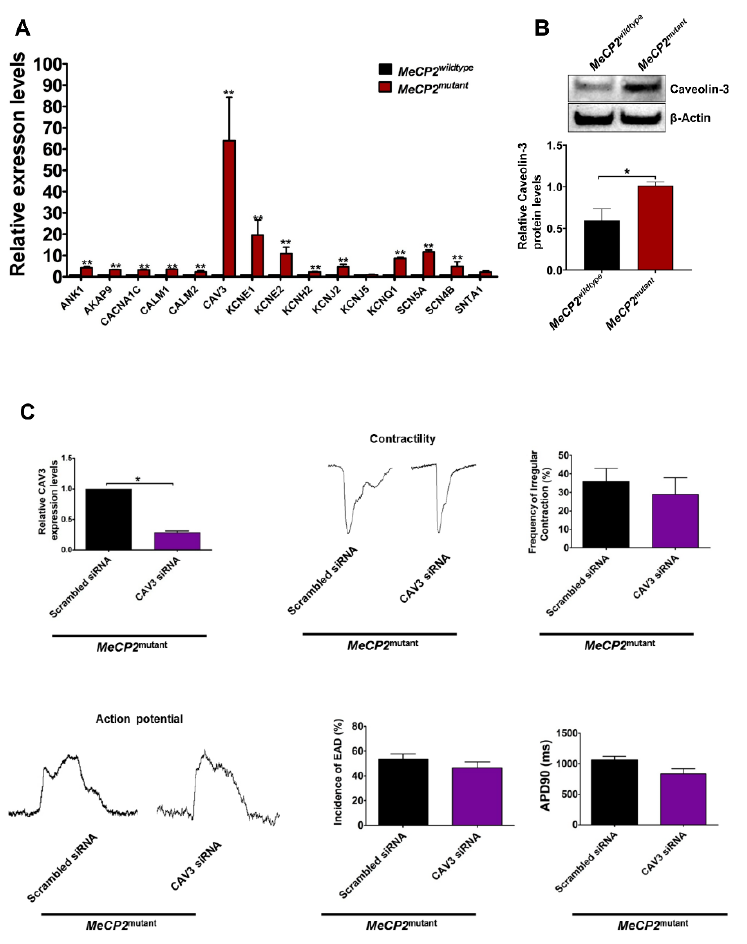
Figure 4. Quantitative PCR analysis of long-QT-syndrome-associated genes. ( A ) Total RNA was extracted from iPSC-derived cardiomyocytes and reverse transcribed into cDNAs. The cDNAs were used as templates for quantitative PCR analysis. N = 4 individual experiments on 4 independent samples collected from each group. ( B ) Western blot analysis of the caveolin-3 protein levels (Caveolin-3-specific antibody: Santa Cruz, sc-5310; β -Actin-specific antibody: Santa Cruz, sc-8432). N = 3 individual experiments on 3 independent samples collected from each group. ( C ) MeCP2 mutant